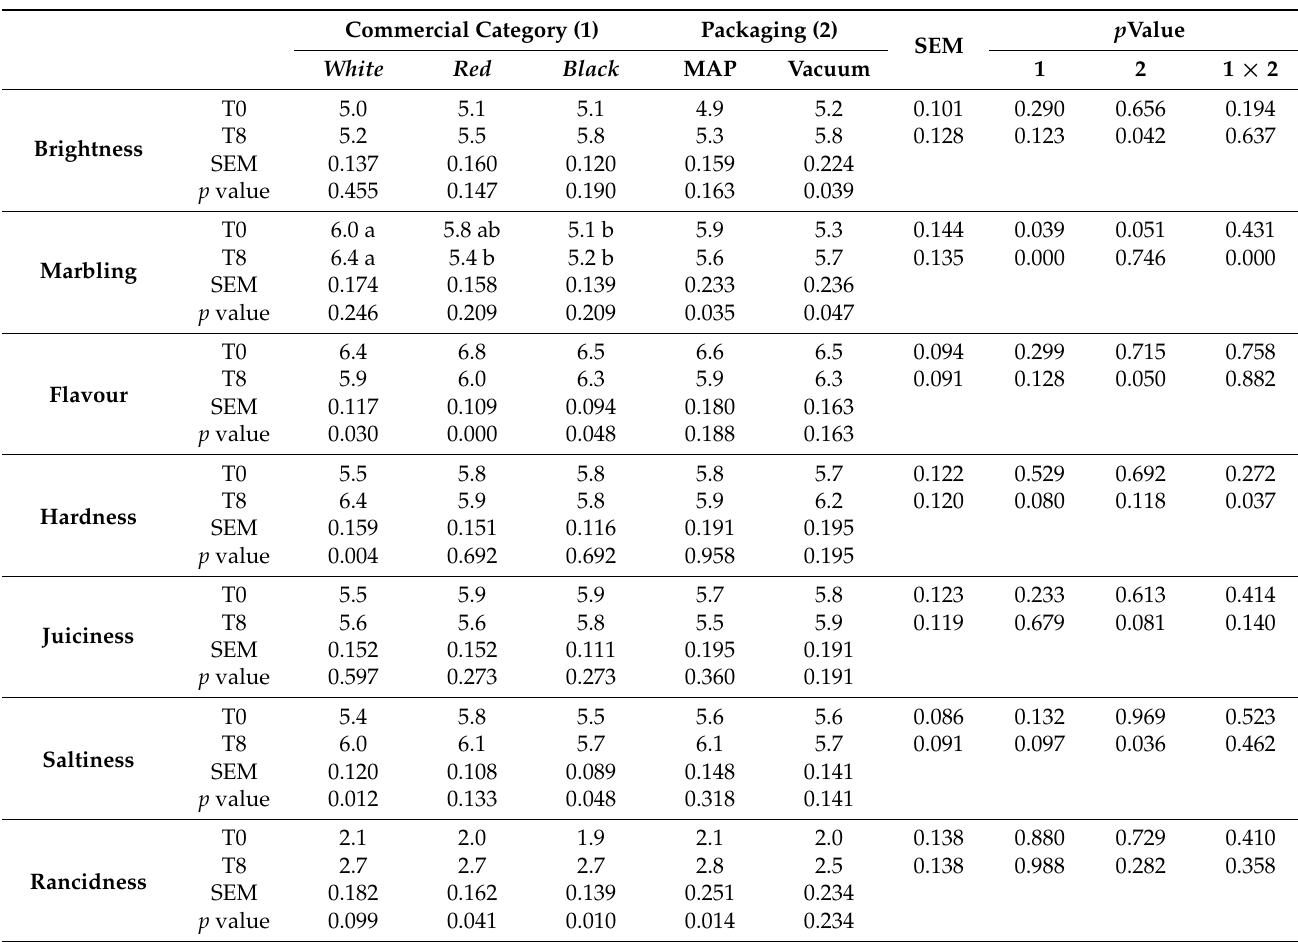
Table 5. Sensory analysis changes of sliced Iberian dry-cured ham from different commercial categories and with different packaging conditions for 12 months of refrigeration